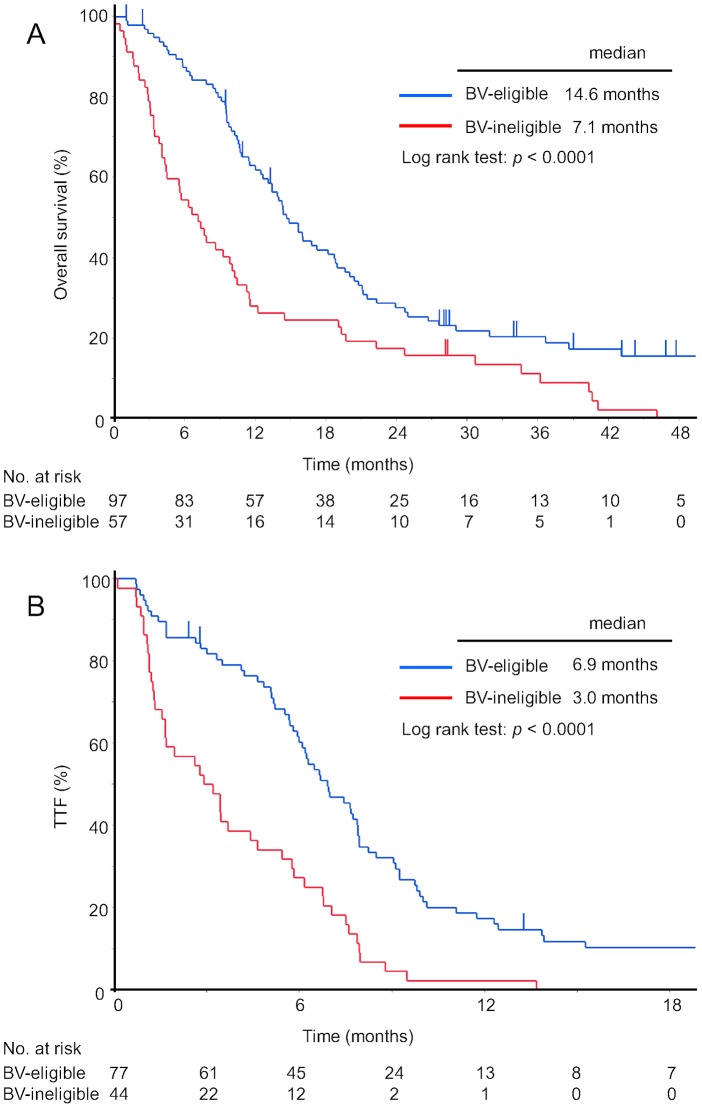
Overall survival and time to treatment failure for patients eligible compared with ineligible for bevacizumab.Kaplan-Meier curves for overall survival (A) and time to treatment failure (B). BV, bevacizumab; TTF, time to treatment failure.